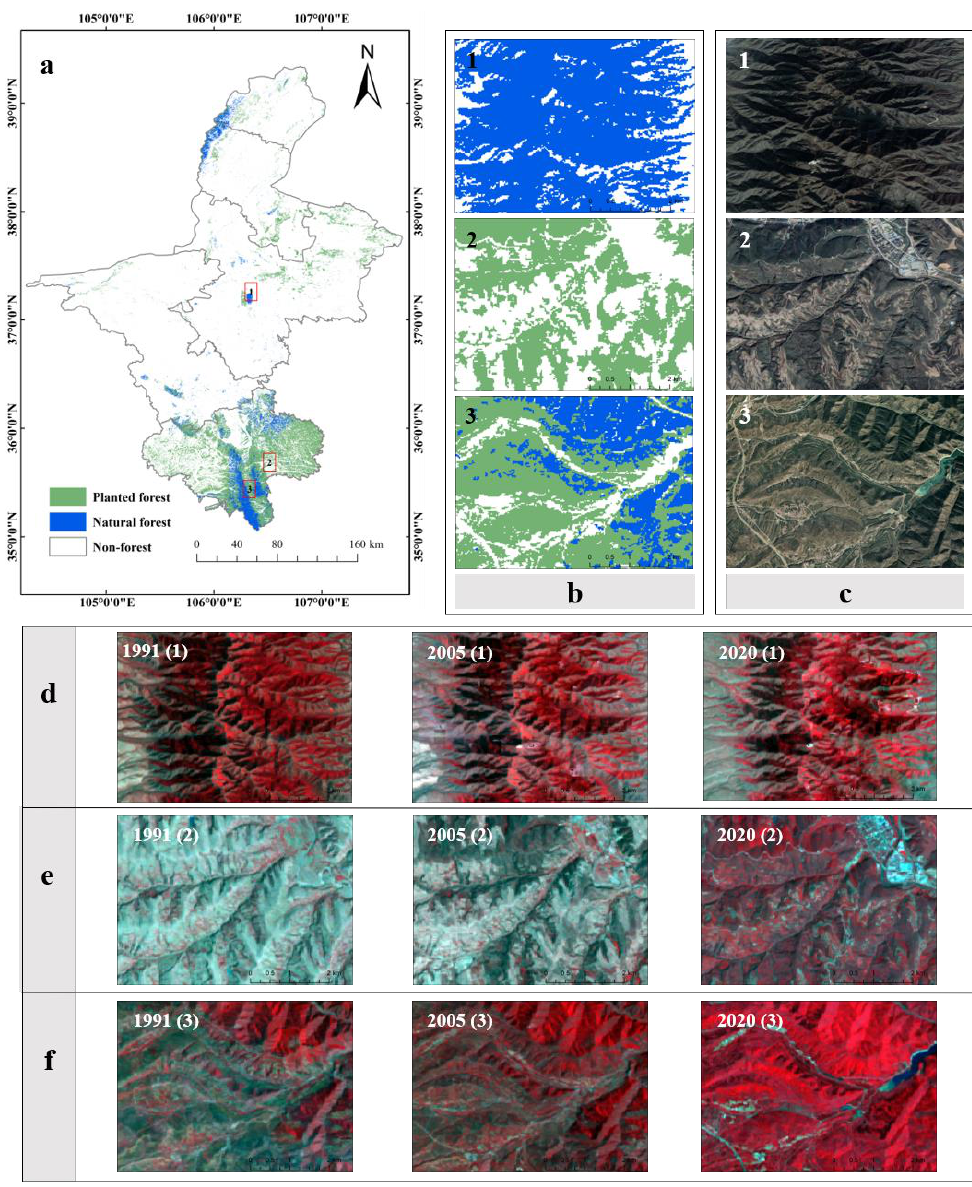
Figure 9. ( a ) Map of the NHAR ’s planted and natural forests in 2020. ( b ) The zoomed-in views of Figure 9. ( a ) Map of the NHAR’s planted and natural forests in 2020. ( b ) The zoomed-in views of three regions corresponding to the labels 1, 2, and 3 in ( a ). ( c ) High-resolution images from Google three regions corresponding to the labels 1, 2, and 3 in ( a ). ( c ) High-resolution images from Google Earth of the three regions. ( d – f ) Landsat images (in false color composite) in 1991, 2005, and 2020 of Earth of the three regions. ( d – f ) Landsat images (in false color composite) in 1991, 2005, and 2020 of the three regions (9 images in total), respectively. the three regions (9 images in total),